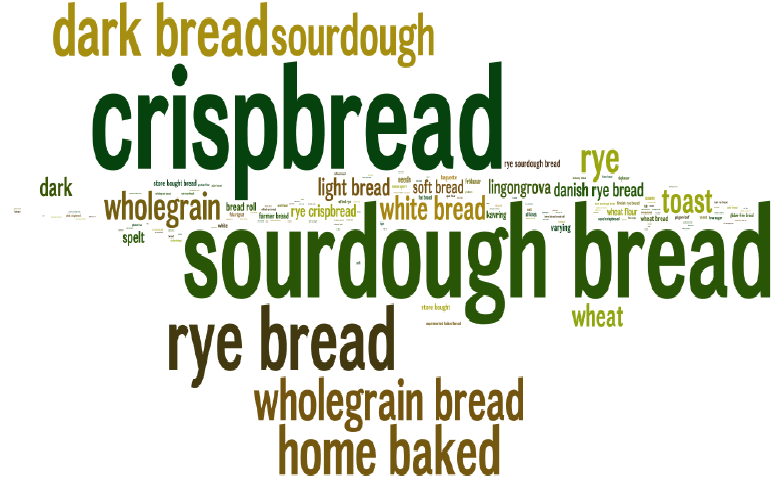
Figure 3. Illustration giving an indication of the popularity of bread types consumed. The figure is based on the qualitative data given in the